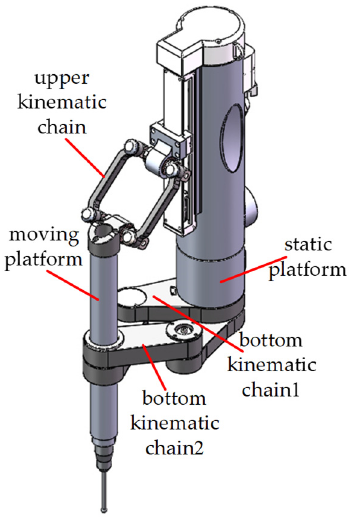
Figure 4. Asymmetrical 3-DOF parallel robot.